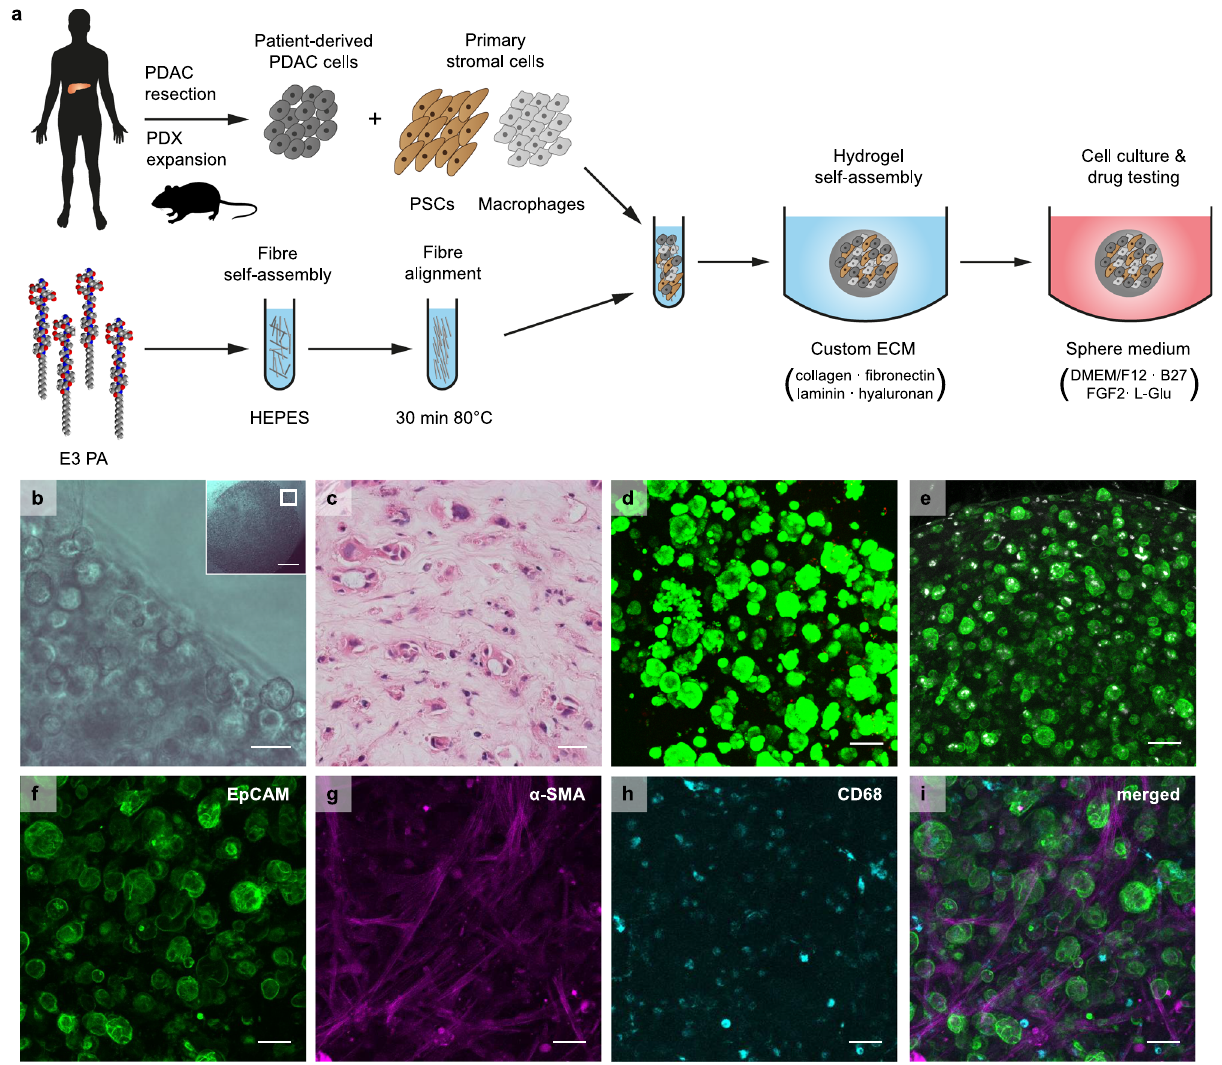
Fig. 2 PA-ECM cultures for the ex vivo modelling of pancreatic cancer. a Schematic illustration of 3D cell culture in PA-ECM. b Bright fi eld micrograph of PDAC cells co-cultured with PSCs and macrophages in PA-ECM; insert indicates imaged area within a 5 µ L hydrogel. Scale bar: 50 µ m. Insert scale bar: 500 µ m. c Haematoxylin (blue) and eosin (red) stain of PA-ECM hydrogel triple culture. Scale bar: 50 µ m. d 3D projection of PDAC cells grown in PA-ECM for 14 days. Living cells were stained with calcein AM (green) and dead cells with ethidium homodimer (red). Scale bar: 100 µ m. e 3D projection of PDAC cells co-cultured with PSCs and macrophages in PA-ECM hydrogels for 7 days and stained for EpCAM (green) and Ki-67 (white). Scale bar: 100 µ m. f – i 3D projection of a PA-ECM hydrogel triple culture. PDAC cells were identi fi ed by EpCAM (green)( f ), PSCs by α -SMA (magenta) ( g ) and macrophages by CD68 (cyan) ( h ) immunostaining. All cell types are shown on ( i ). Scale bars: 50 µ